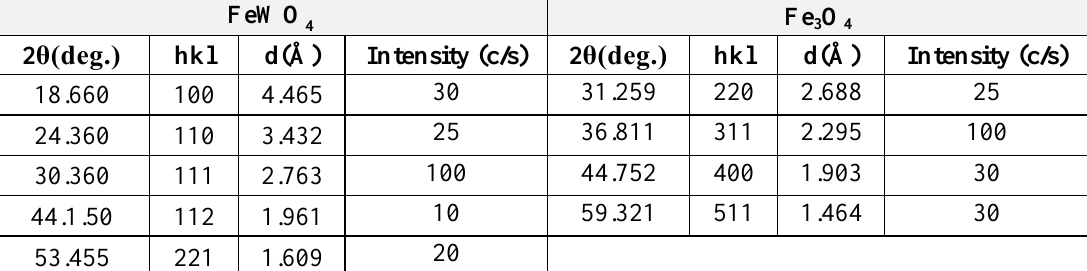
Fig. 3: XRD spectra of S3 Table 5: Results data of XRD S3 sample .